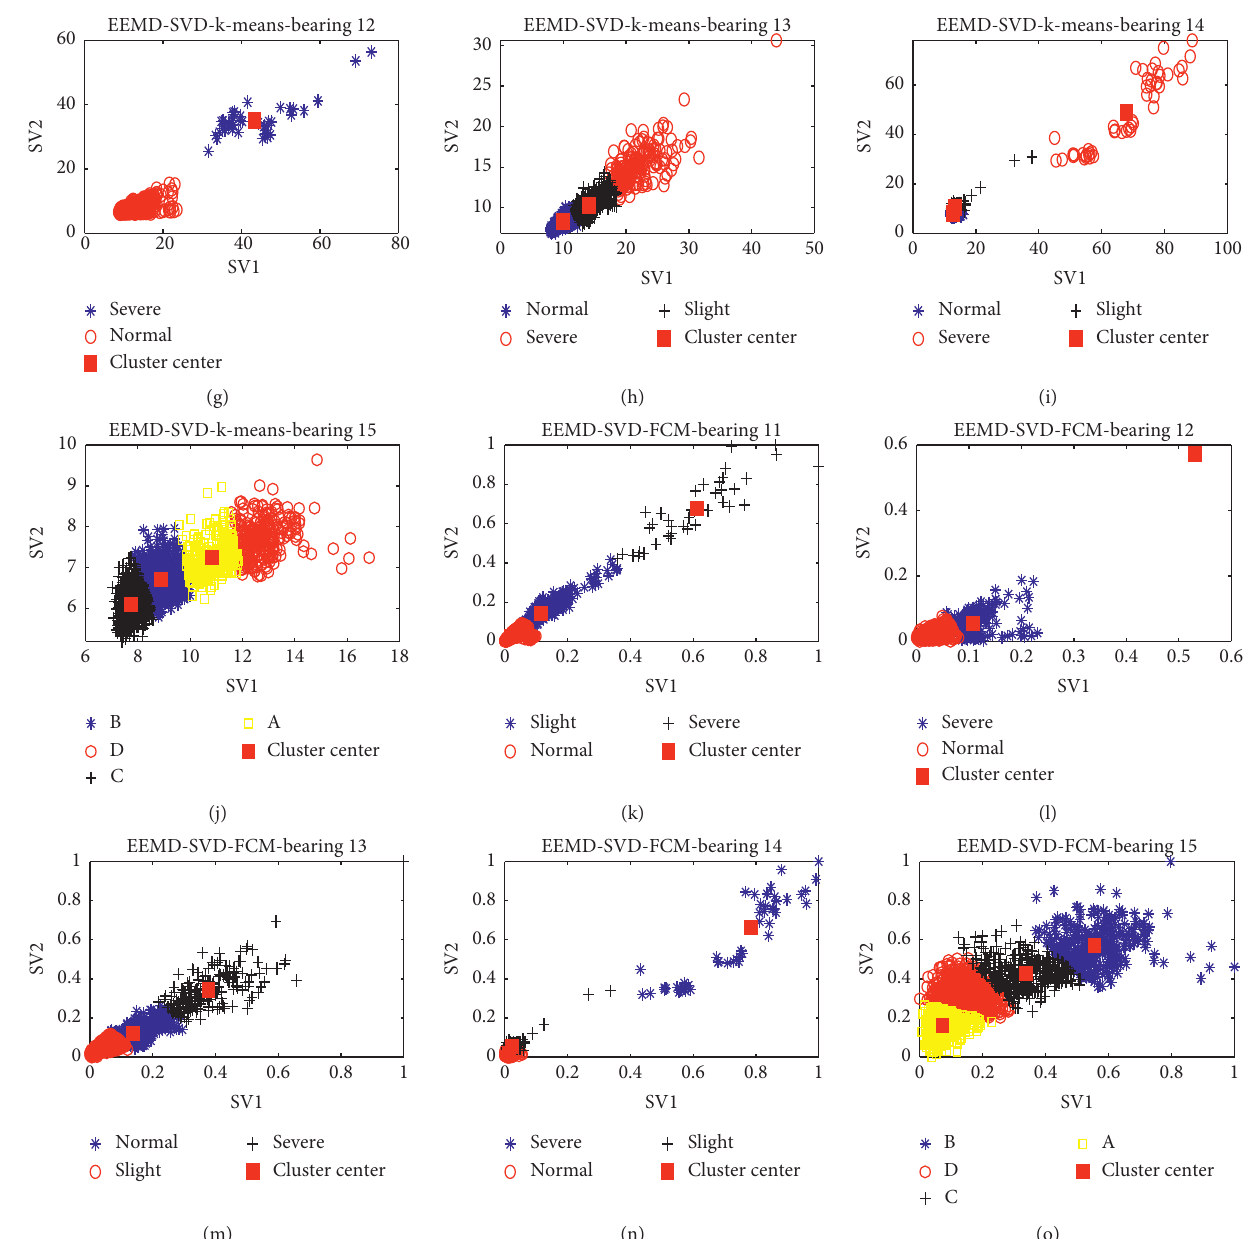
Figure 25: Two-dimensional clustering figure of bearings using EEMD-SVD-k-medoids/k-means/FCM. (a) Bearing 11. (b) Bearing 12. (c) Bearing 13. (d) Bearing 14. (e) Bearing 15. A: Normal1; B: Normal2; C: Slight; D: